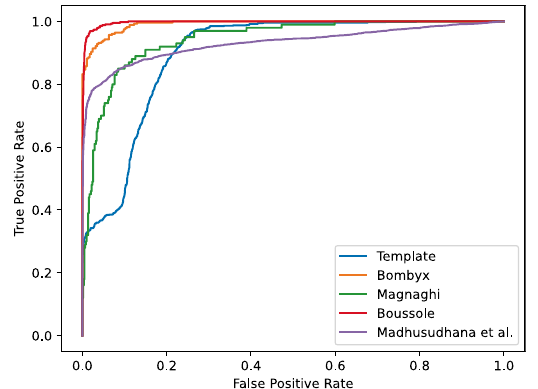
Figure 4. ROC curves for each test set (the two remaining sources serving as training set) and for the template matching method. The ROC curve of the model over the dataset published by Madhusudhana et al. 33 is also